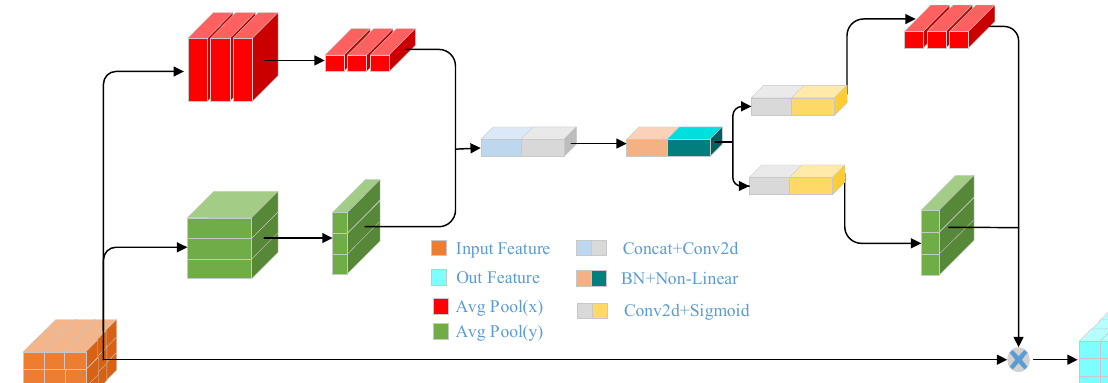
Figure 4. The structure of the CA mechanism.